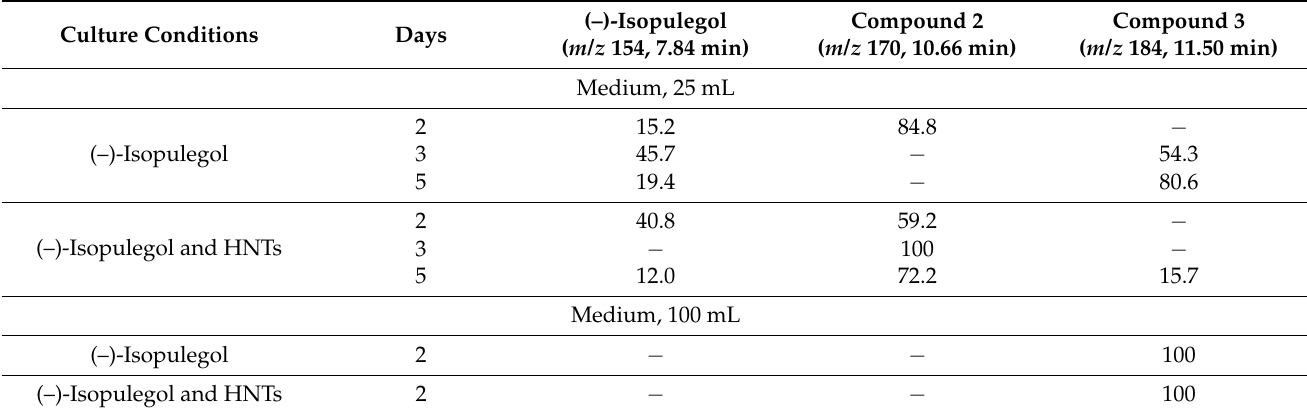
Table 1. Changes in ethyl acetate extract (%) composition during biotransformation of (–)-isopulegol by R . rhodochrous IEGM 1362.